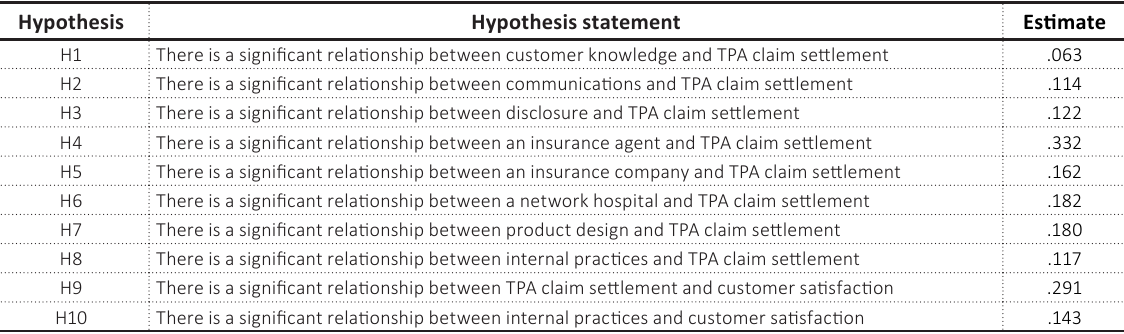
Table 7. Summary of regression